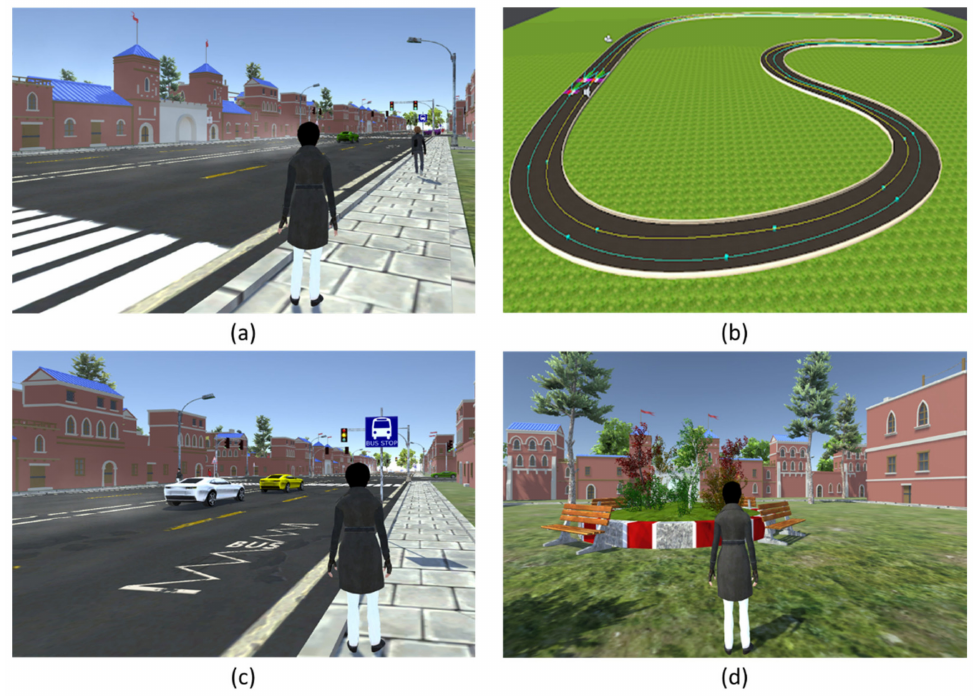
Figure 7. ( a ) represents the virtual city, ( b ) shows the waypoint system, ( c ) depicts cars, walkways, bus stops, and road signs, and ( d ) shows a park in our simulated